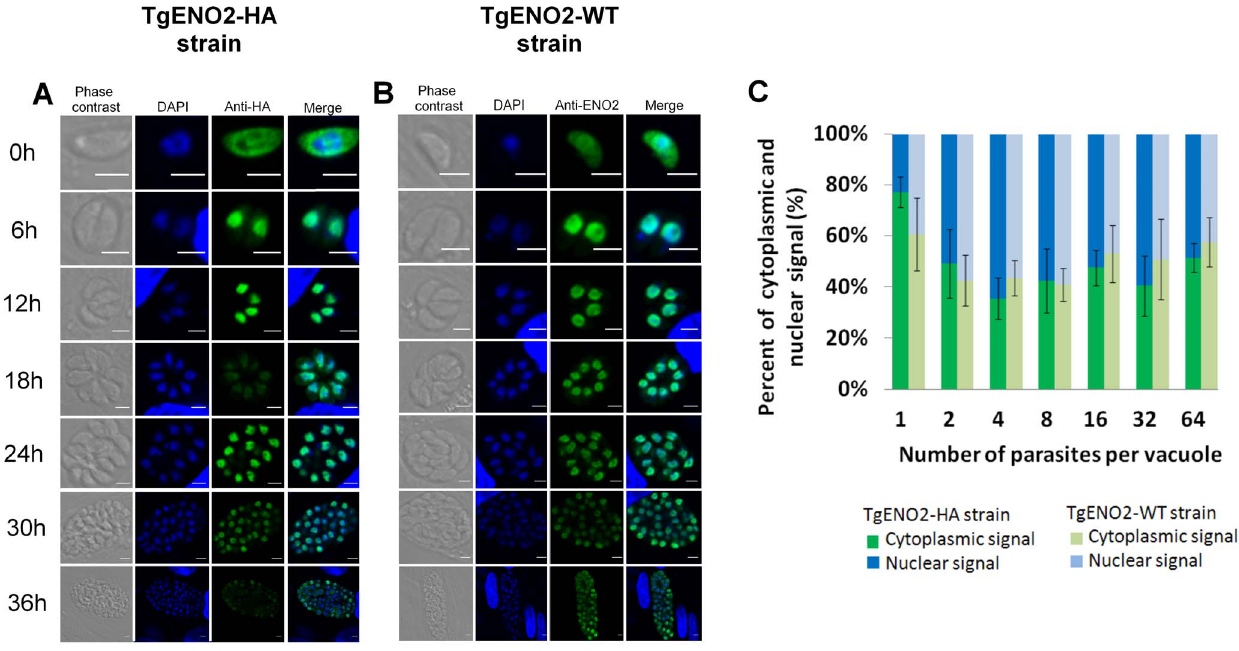
Figure 2. Expression of ectopic TgENO2-HA and native TgENO2 proteins is predominantly nuclear and increases with intracellular replication of T.gondii . A) Kinetics of nuclear accumulation of ectopic TgENO2-HA protein in transgenic tachyzoites at different time points (0, 6, 12, 18, 24, 30, and 36 h post-infection) during the intracellular division cycle. Intracellular dividing transgenic tachyzoites were fixed and stained with rabbit polyclonal anti-HA and DAPI followed by confocal imaging. Scale bars, 5 m m. B) Kinetics of nuclear accumulation of native TgENO2 protein in wild type T. gondii tachyzoites at different time points (0, 6, 12, 18, 24, 30, and 36 h post-infection) during the intracellular division cycle. Intracellular dividing transgenic tachyzoites were fixed and stained with rabbit polyclonal anti-ENO2 antibodies and DAPI followed by confocal imaging. Scale bars, 5 m m. C) Quantification of cytoplasmic and nuclear levels of ectopic TgENO2-HA and native TgENO2 in intracellular dividing tachyzoites of T. gondii . Experiments were repeated three times (n=3, P , 0.001). Quantifications were performed on at least 8–10 independent intracellular